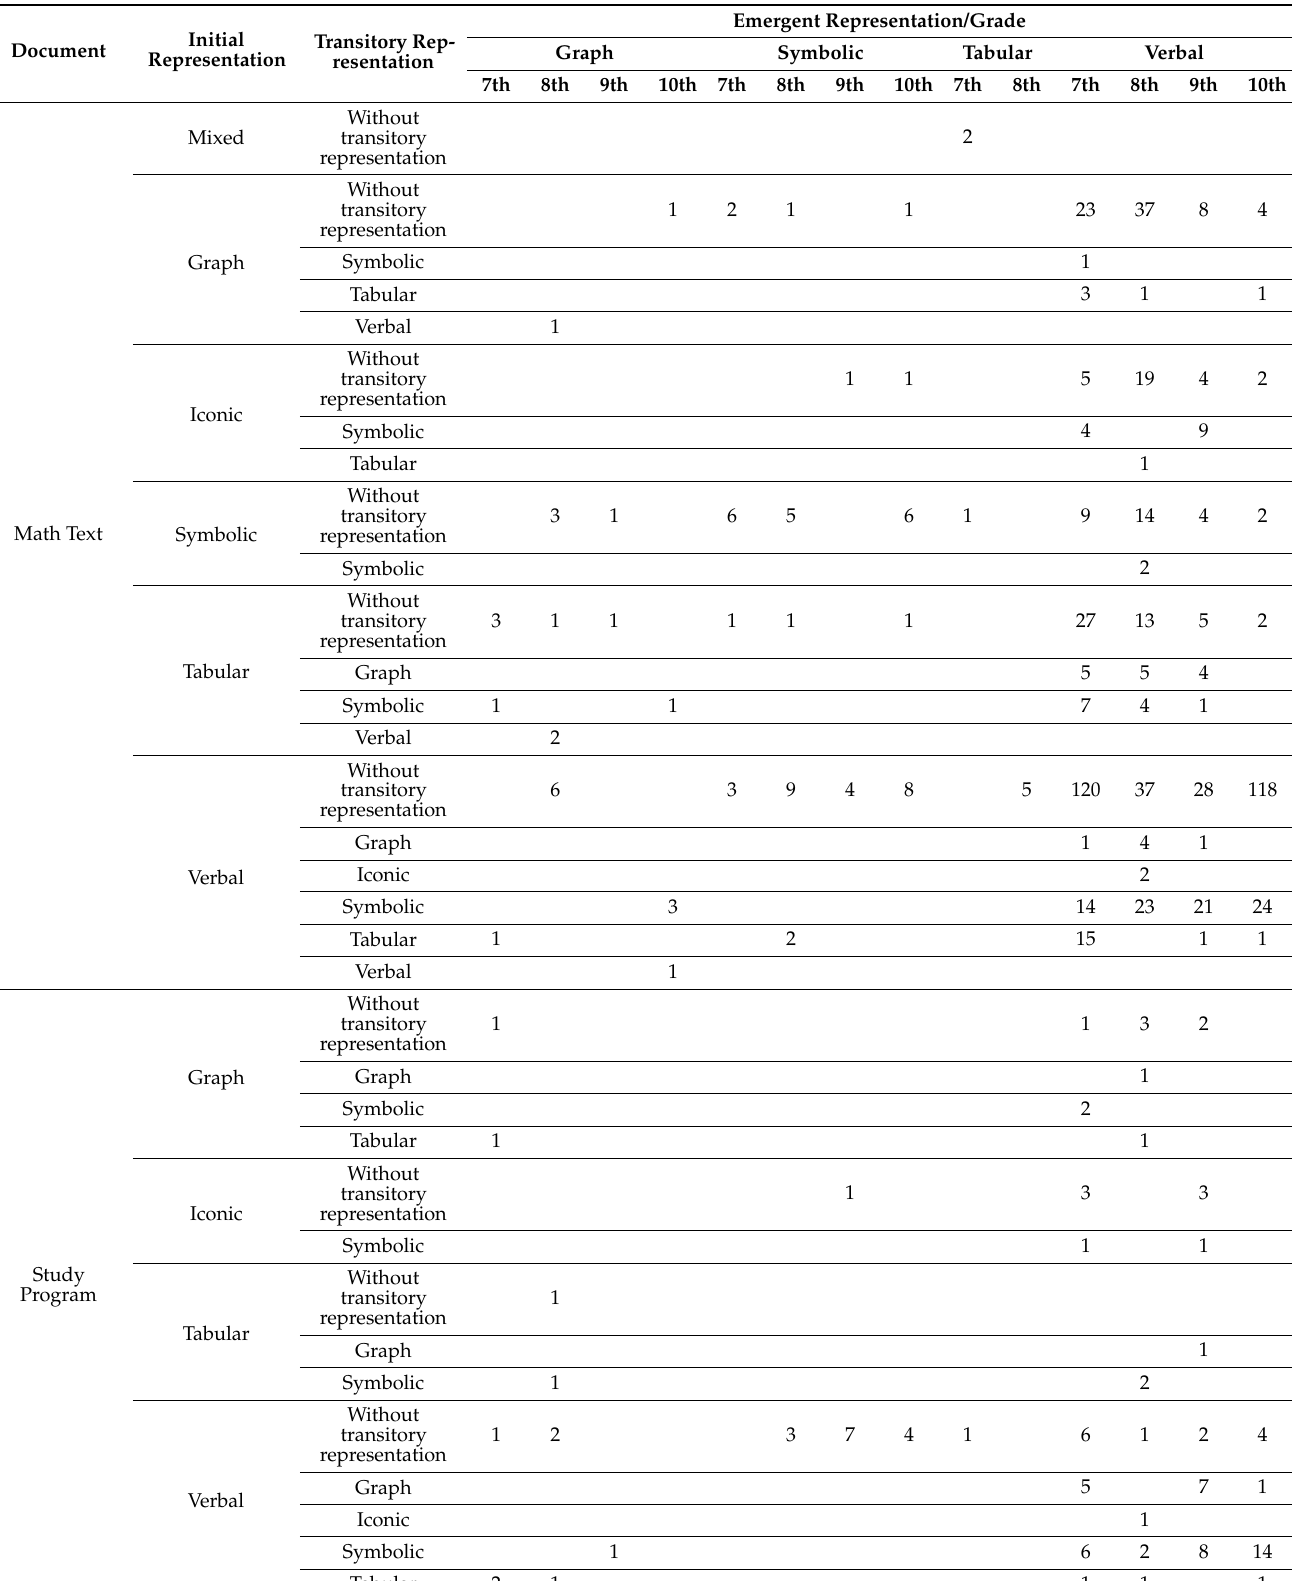
Table 3. Presence of types of representations (Source: Prepared by the